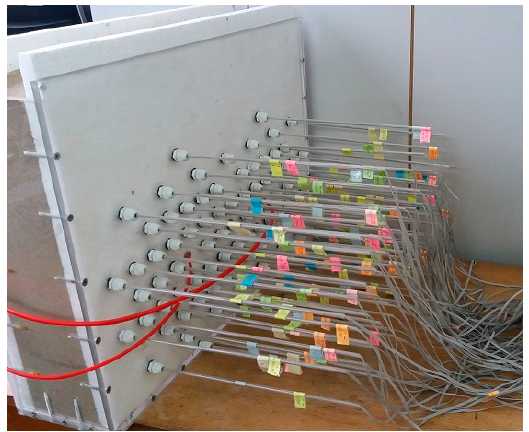
Figure 11. A photo of the research installation.